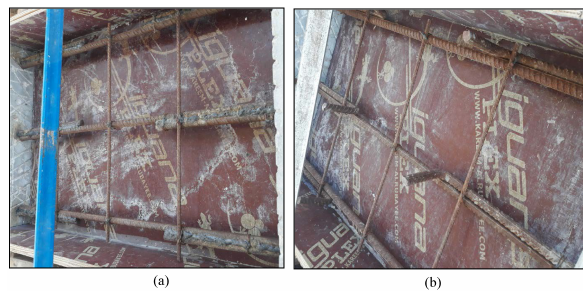
Figure 6: New to old steel bonding by: a) welding and b) making a hook with 90 ∘ angle.